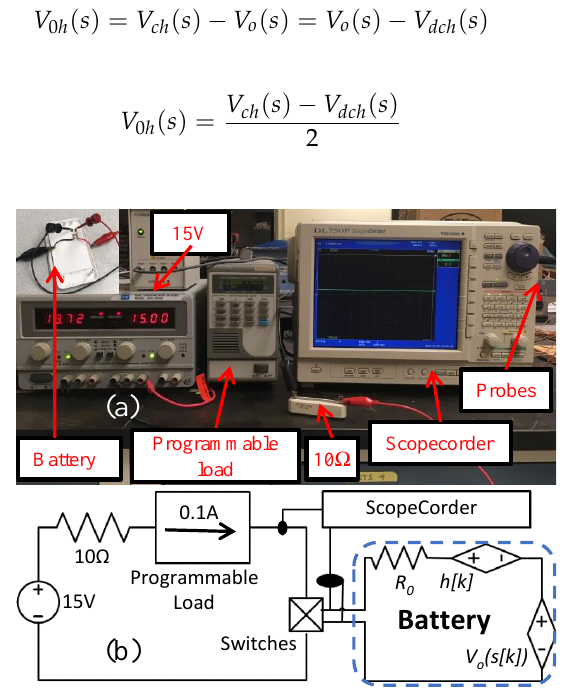
Figure 2. Equivalent circuit model (ECM) experiment: ( a ) test bench; ( b ) block diagram.